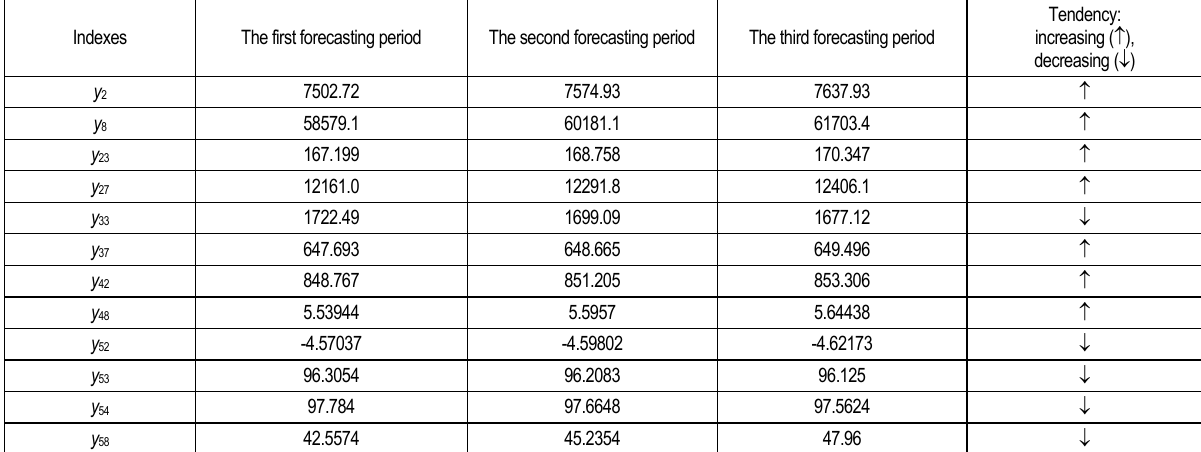
Table 8. Forecasting meanings of indexes of socioeconomic state of SA